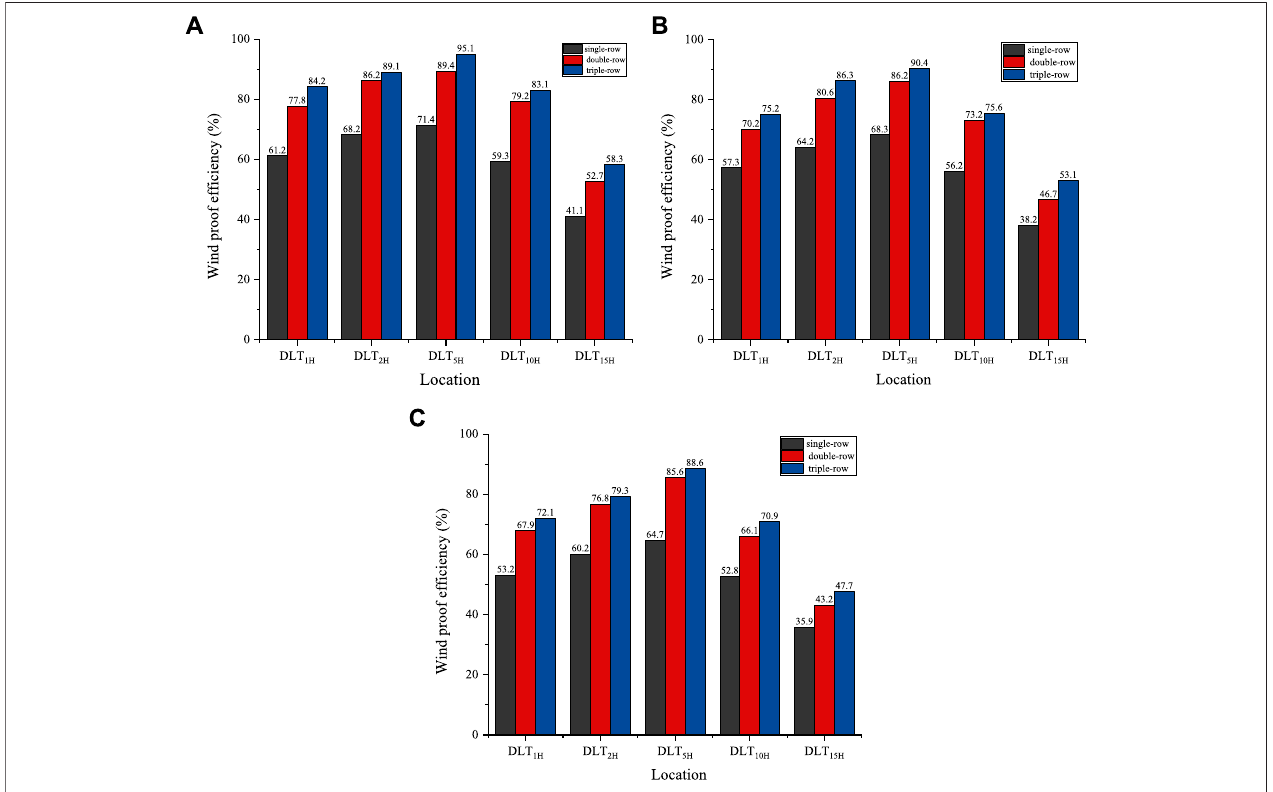
FIGURE 9 | The relationship between windbreak ef fi ciency and forest belt downwind distance under different incoming wind velocities. (A) :V = 8 m · s − 1 , (B) : V = 12 m · s − 1 , (C) : V = 16 m · s − 1 .